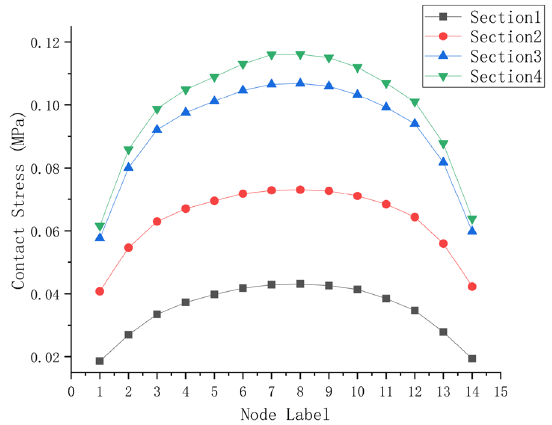
Figure 9 Contact stress nephogram of cross-section under single concentrated